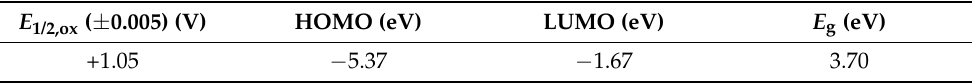
Figure 3. ( a ) Anodic cyclic voltammograms of H5T including first (black curve) and subsequent (red curve) oxidation steps. The sample solution consisted of H5T in dichloromethane (1 × 10 − 3 mol dm − 3 ) with 0.2 mol dm − 3 of tert -butylammonium tetrafluoroborate (Bu 4 NBF 4 ) as an electrolyte and was scanned at a rate of 0.10 V s − 1 . ( b ) Absorbance squared vs the photon energy used for determination of the gap energy of H5T by extrapolation of the first absorption peak to zero (inset). Table 1. Half-wave oxidation potential, HOMO and LUMO energy levels, and optical bandgap of H5T.